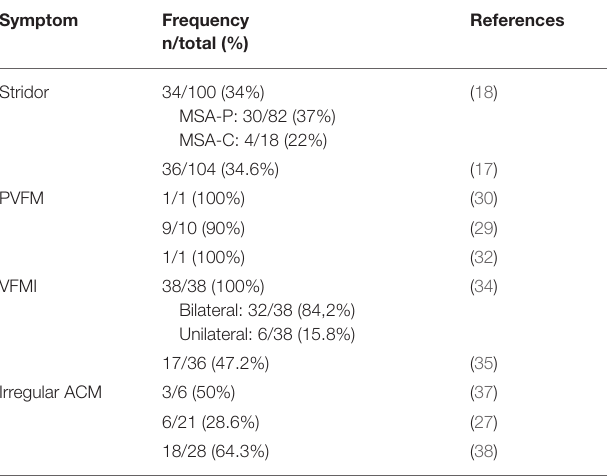
TABLE 1 | Overview and frequency of typical laryngeal findings in MSA.